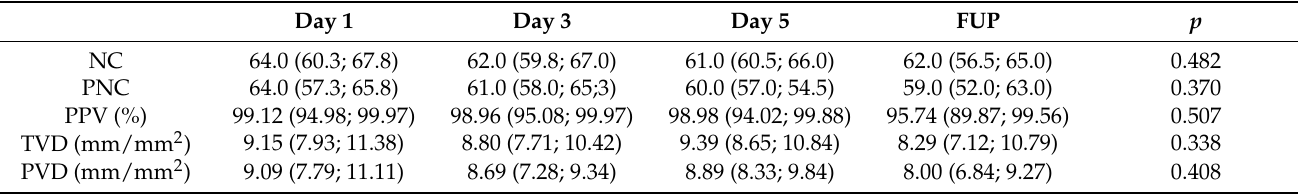
Table 3. Chronological sequence of MC parameters in TTS patients.